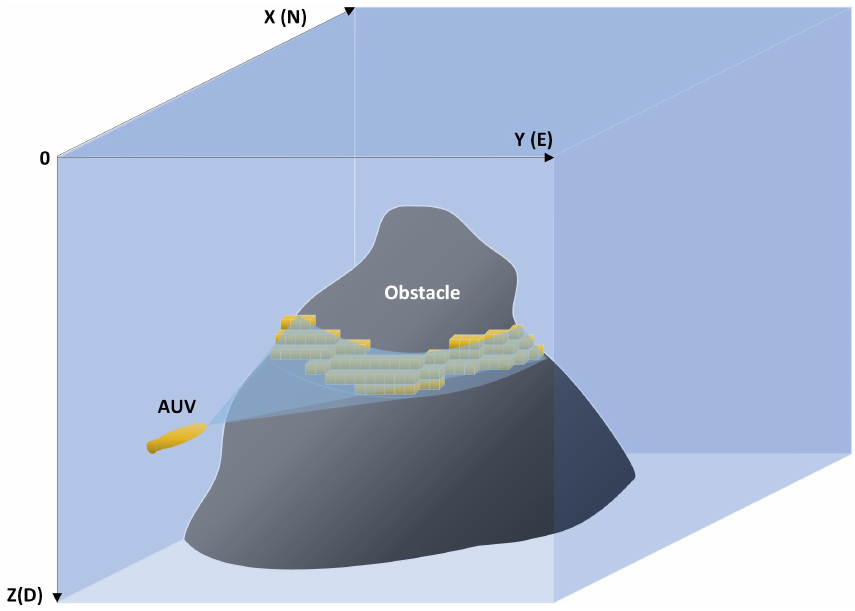
Figure 3. Obstacle detection and its modeling using occupancy grid